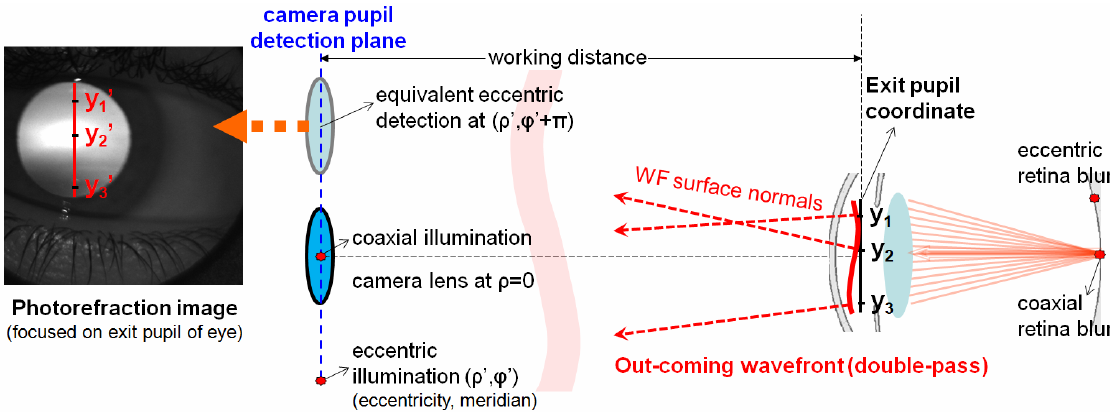
Figure 2. Illustration of the eccentric photorefraction detection of double-pass